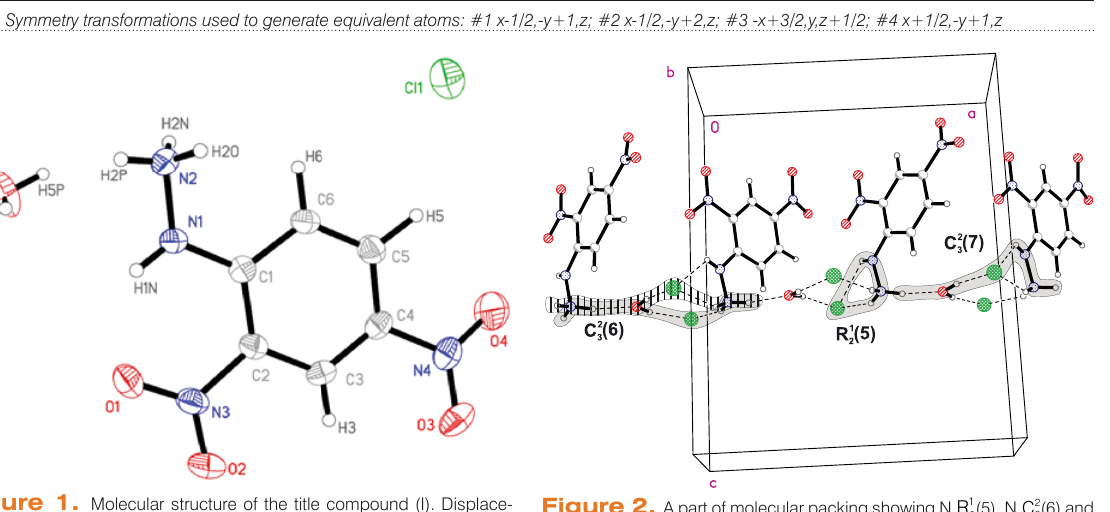
Figure 1. Molecular structure of the title compound (I). Displace- ment ellipsoids are drawn at the 50% probability level. Hydrogen atoms are shown as small spheres of arbitrary